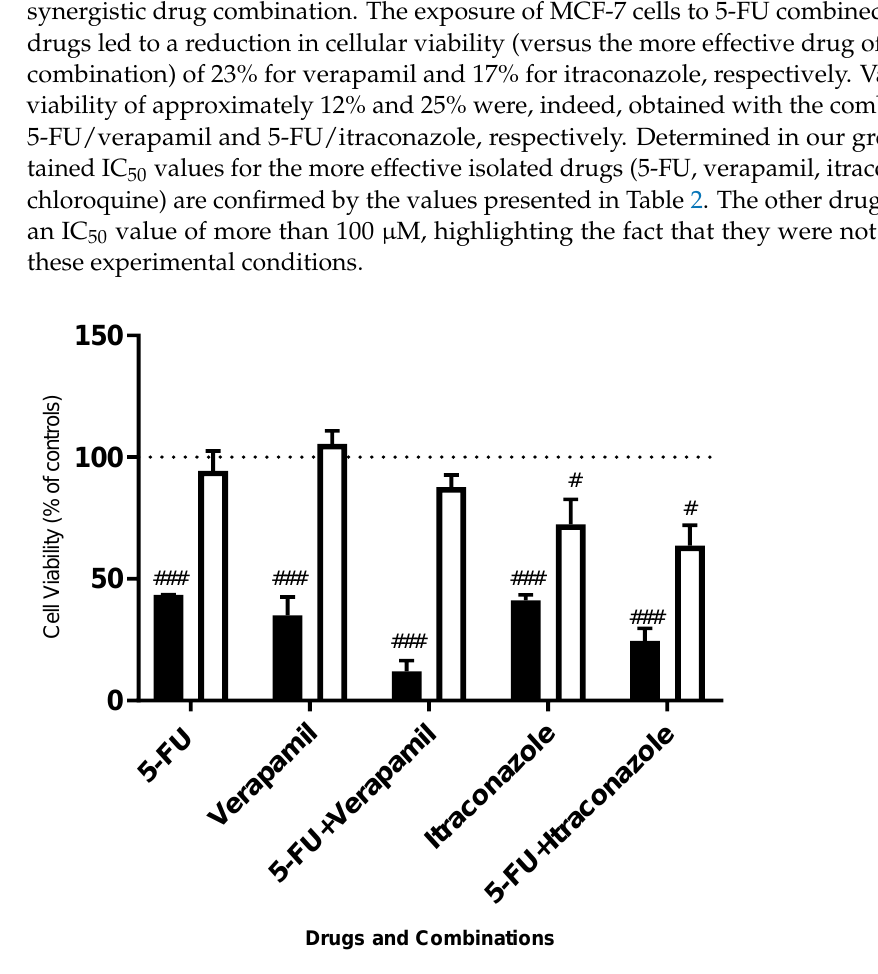
Figure 2. Cell viability values of 5-FU, verapamil, itraconazole and the combination of 5-FU with verapamil and itraconazole in MCF-7 cells (black bars) and MCF-10A cells (white bars), 72 h. All the compounds were added to cells in sextuplicates. The results (mean ± SEM) are presented as a percentage of the control (100%) of four independent experiments. ### p < 0.001 and # p < 0.05 vs. controls; Adapted from [7].